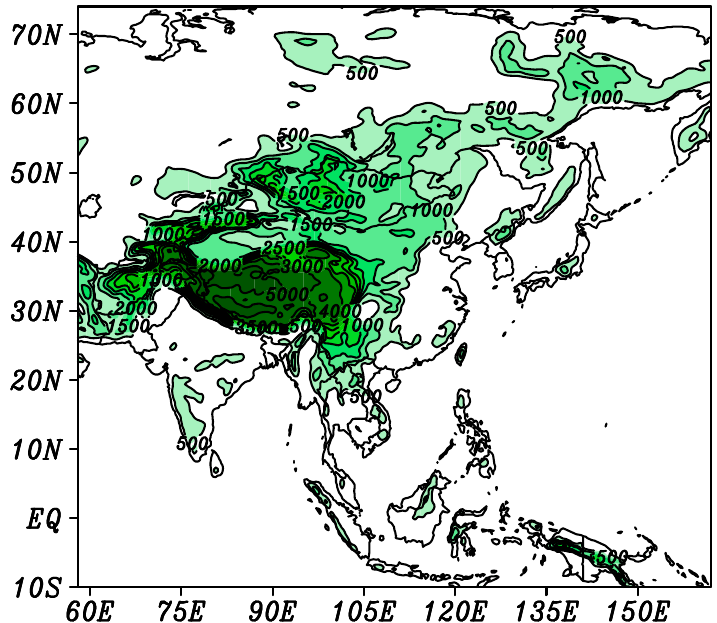
Figure 1. Regional model (GRIMs) domain. Contour and shading represent the terrain height (m).